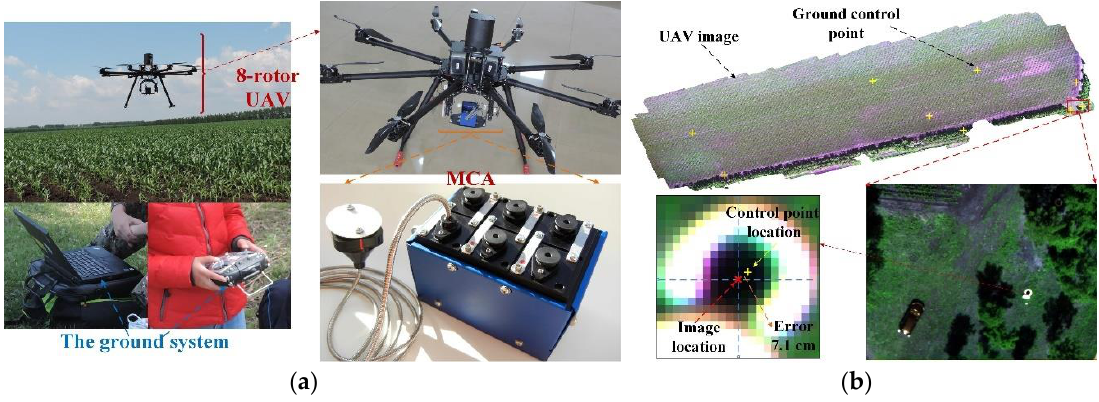
Figure 2. The components of the UAV platform ( a ) and geometric correction accuracy ( b ).